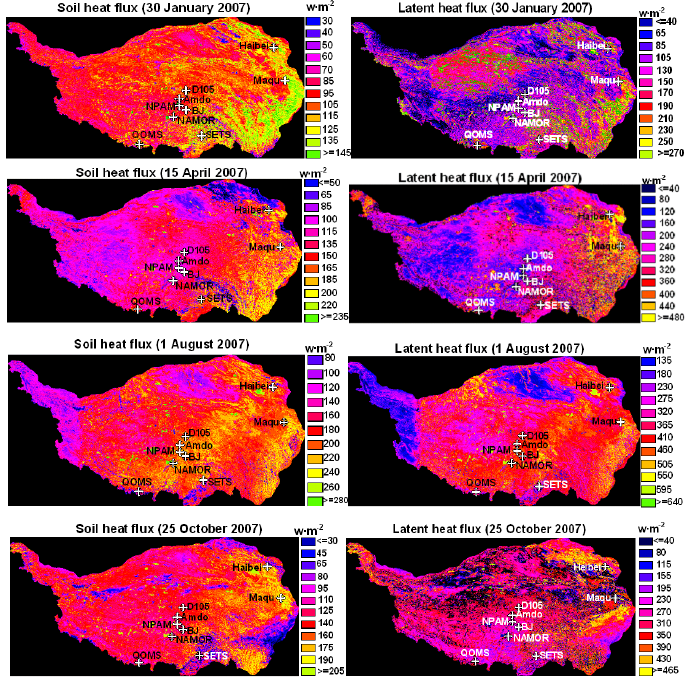
Fig.4. The distribution maps of soil heat flux and latent heat flux over the Tibetan Plateau area. Fig. 4. The distribution maps of surface soil heat flux and latent heat flux over the Tibetan Plateau